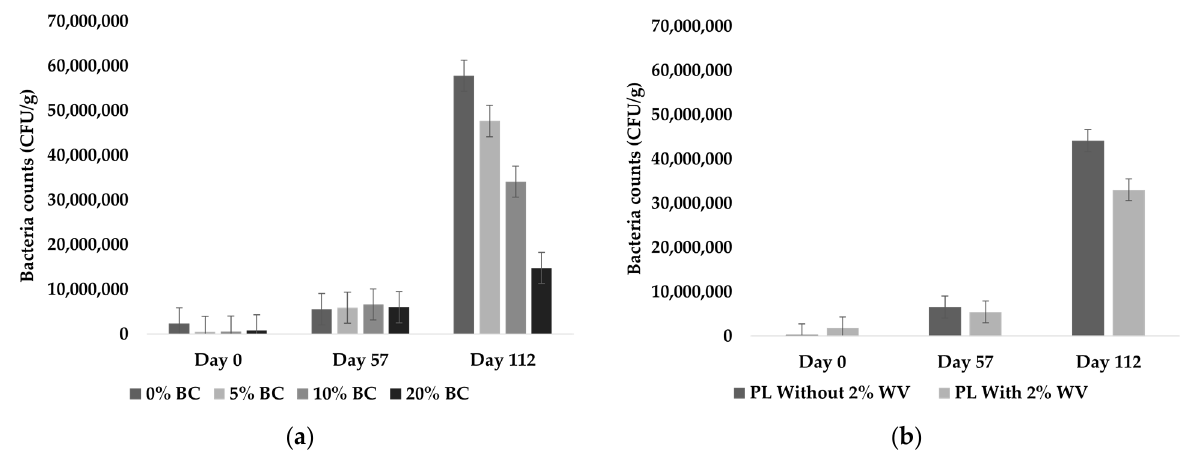
Figure 6. Bacteria counts for all BC inclusion rates, including treatments with and without WV ( a ), and WV level ( b ) as independent fixed effects.